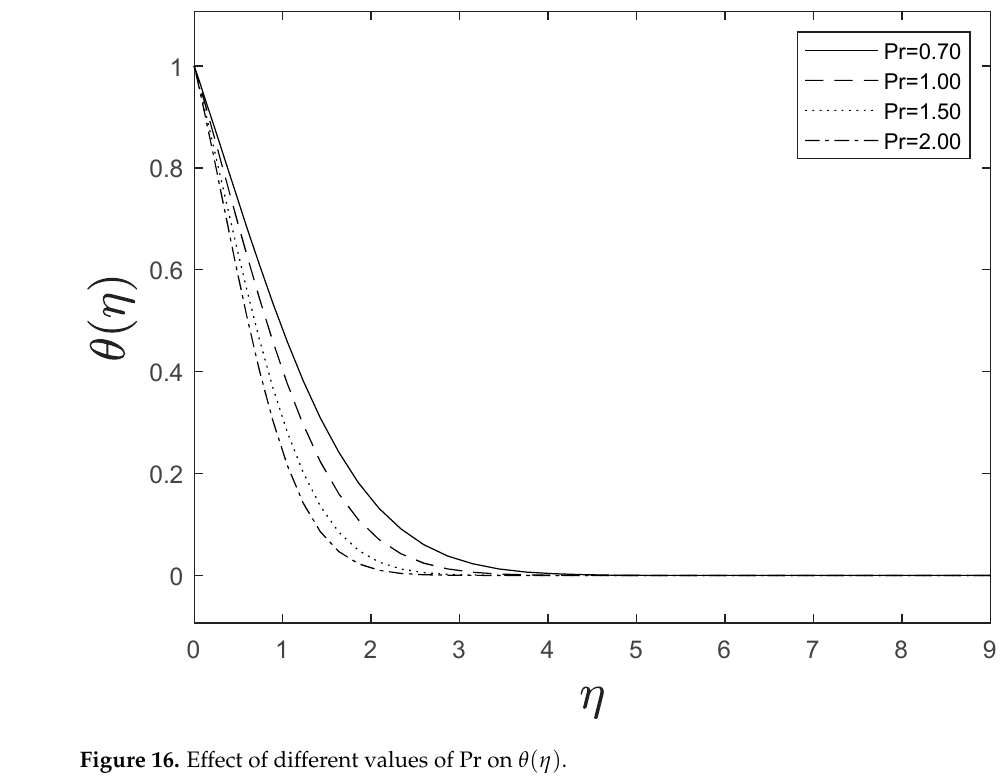
Figure 15. Effect of different values of